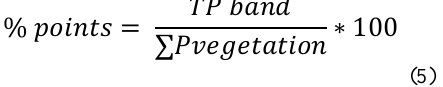
Figure 8. Burned area